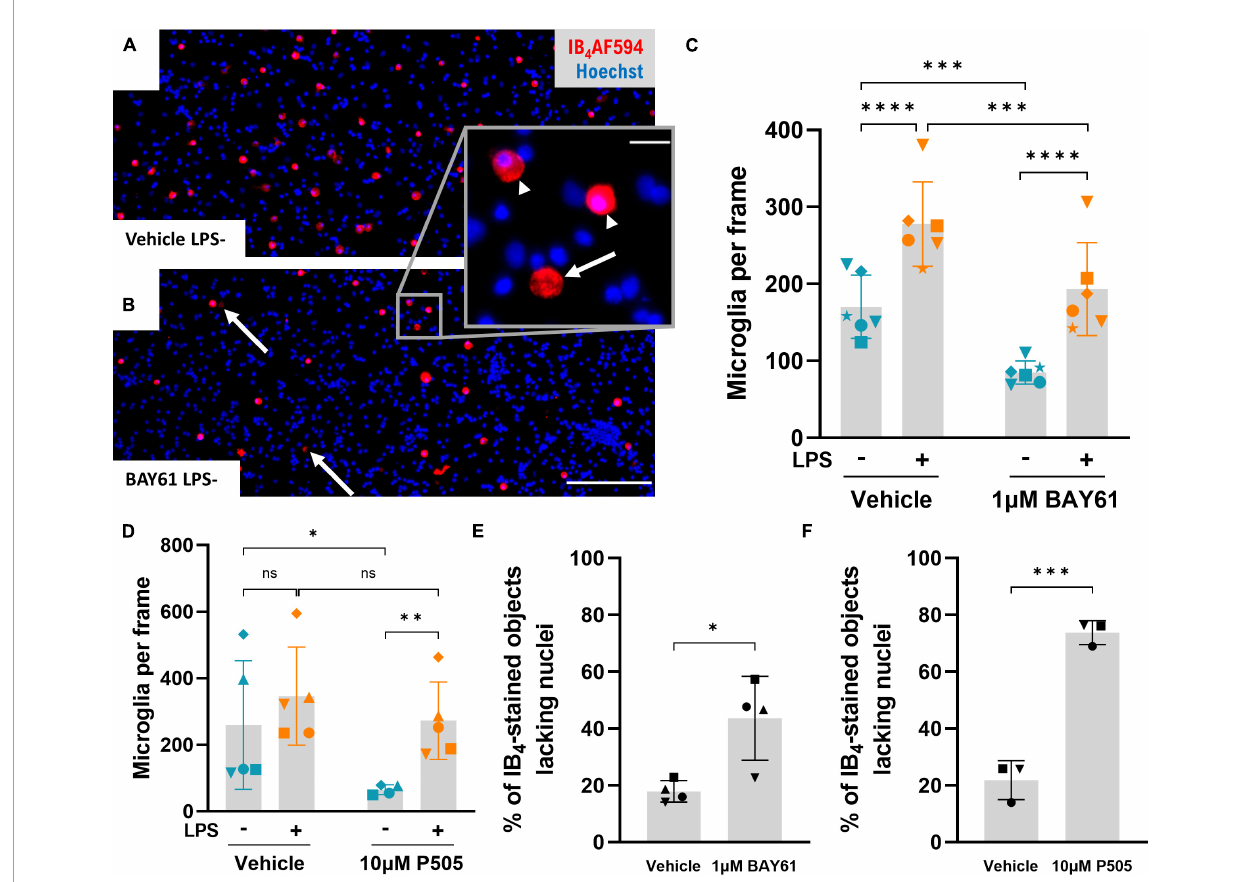
FIGURE3 Syk inhibitors deplete microglia in the absence of LPS. (A,B) Representative 10x images (cropped) of LPS-untreated primary rat neuron-glia cultures treated ± BAY61 (1 µ M) for 3 days and stained with Hoechst 33342 and IB 4 -AF594. Scale bar = 100 µ m. Arrows indicate ghost-like microglia (IB 4 -stained objects lacking any nuclear staining). (B) Magnified view of a ghost-like microglia (arrow) adjacent to intact microglia (indicated by arrowheads). Scale bar = 10 µ m. (C) Average microglial counts per image in neuron-glia cultures treated ± BAY61 (1 µ M) and ± LPS (100 ng/ml) for 3 days (DIV10). RM 2-way ANOVA with Šídák’s post-hoc test. (D) Average microglial counts per image in neuron-glia cultures treated ± P505 (10 µ M) and ± LPS (100 ng/ml) for 3 days (DIV10). RM mixed-effects analysis with Šídák’s post-hoc test. (E) Percentage of IB 4 -stained objects which lack nuclear DNA staining in images from LPS-untreated neuron-glia cultures treated ± BAY61 (1 µ M) for 3 days (DIV10). Paired t -test. (F) Percentage of IB 4 -stained objects which lack nuclear DNA staining in images from LPS-untreated neuron-glia cultures treated ± P505 (10 µ M) for 3 days (DIV10). Paired t -test. All panels: each datapoint represents the mean of three technical replicates. Number of biological repeats = number of datapoints per column. ∗ p < 0.05, ∗∗ p < 0.01, ∗∗∗ p < 0.001, ∗∗∗∗ p <